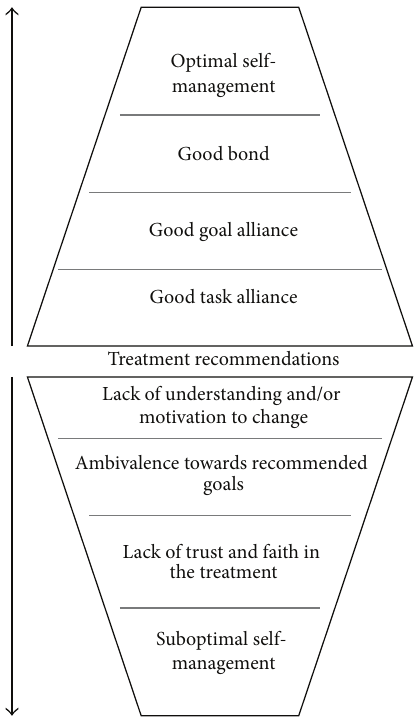
Figure 1: Conceptual model of the role of working alliance in diabetes